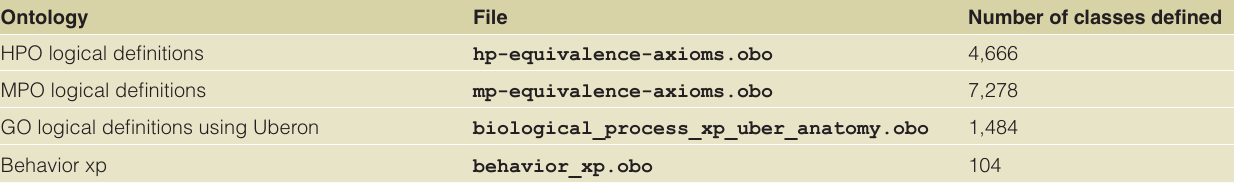
Table 3. Current statistics on the data contained in the used cross-product files. HPO and MPO files downloaded from http://code.google.com/p/phenotype-ontologies. Behaviour files downloaded from http://code.google.com/p/behavior-ontology. GO-xp file downloaded from http://obofoundry.org/cgi-bin/detail.cgi?id=biological_process_xp_uber_anatomy.